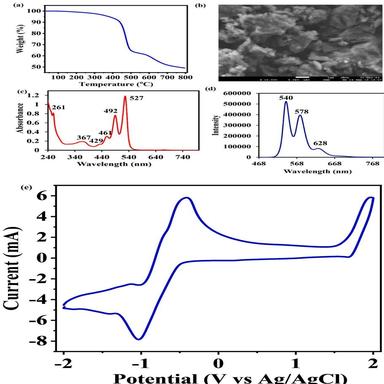
(a) Thermogravimetric analysis (TGA) of PDI-NDI-PDI; (b) FE-SEM scanning electron microscopy image of PDI-NDI-PDI; (c) UV–Visible spectra of PDI-NDI-PDI (1 × 10− 5 M) in DCM; (d) fluorescence emission spectra of PDI-NDI-PDI (1 × 10− 5 M) in DCM; (e) CV of PDI-NDI-PDI in dichloromethane with 0.1 M tetrabutylammonium hexafluoro phosphate electrolyte. CV of PDI-NDI-PDI within potential window of − 2.0 to 2.0 V at scan rate 10 mV s − 1 .